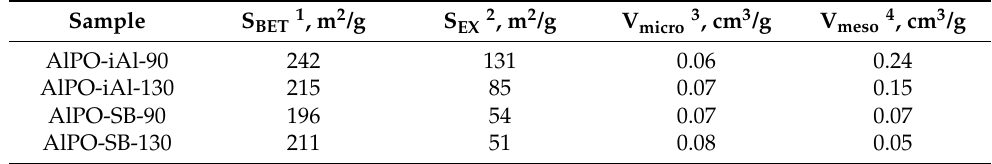
Table 3. Characteristics of the porous structure of molecular sieves.